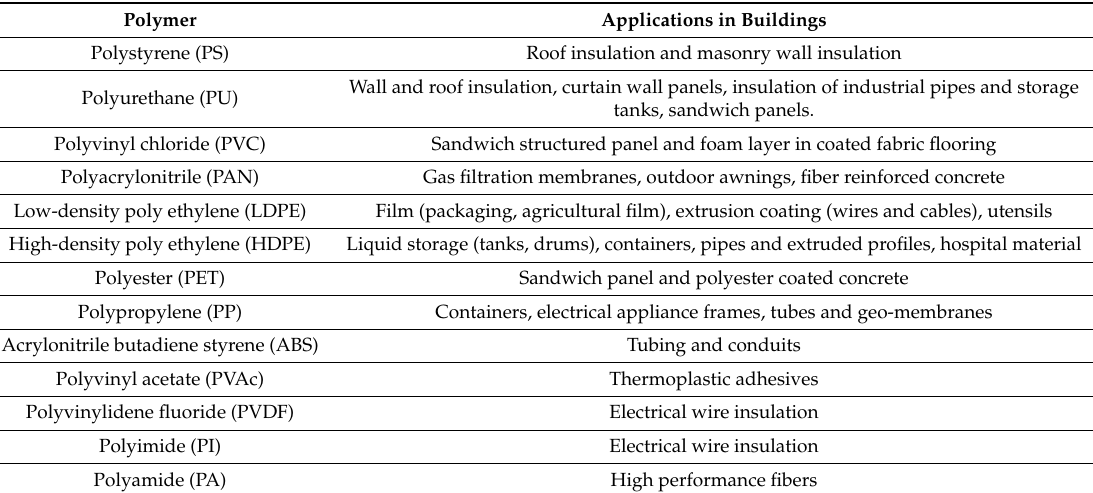
Table 1. Polymers Commonly Used for Building